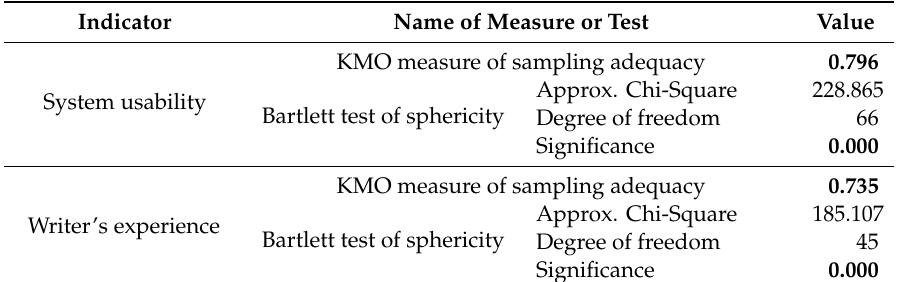
Table 13. The KMO measure values and the significance values of the Bartlett’s test of the collected questionnaire data of the two indicators of system usability and writer’s